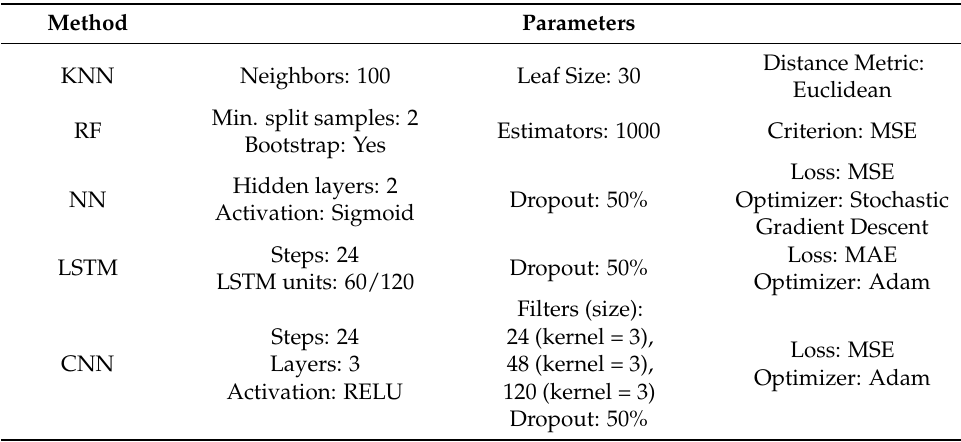
Table 2. Parameters and hyper-parameters of the ML and DL